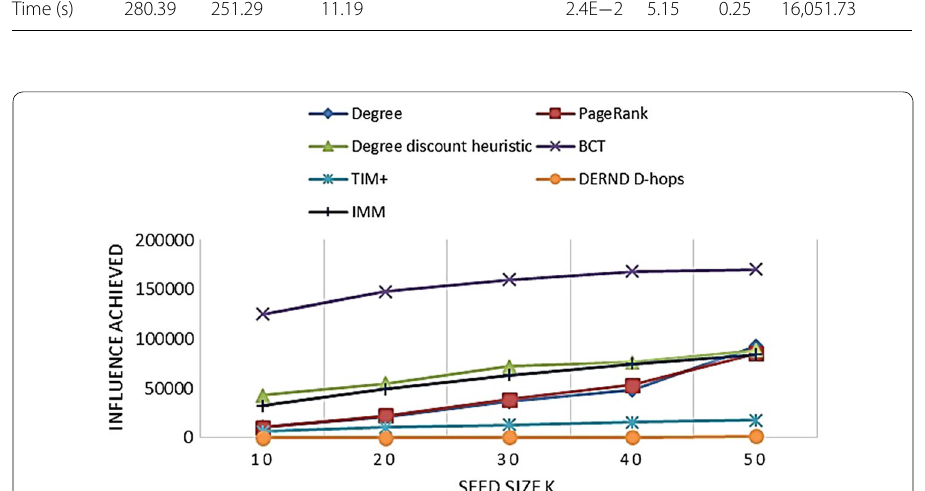
Table 10 Runtime of algorithms on Eu‑Email data for K Algorithm Degree PageRank Degree discount heuristic